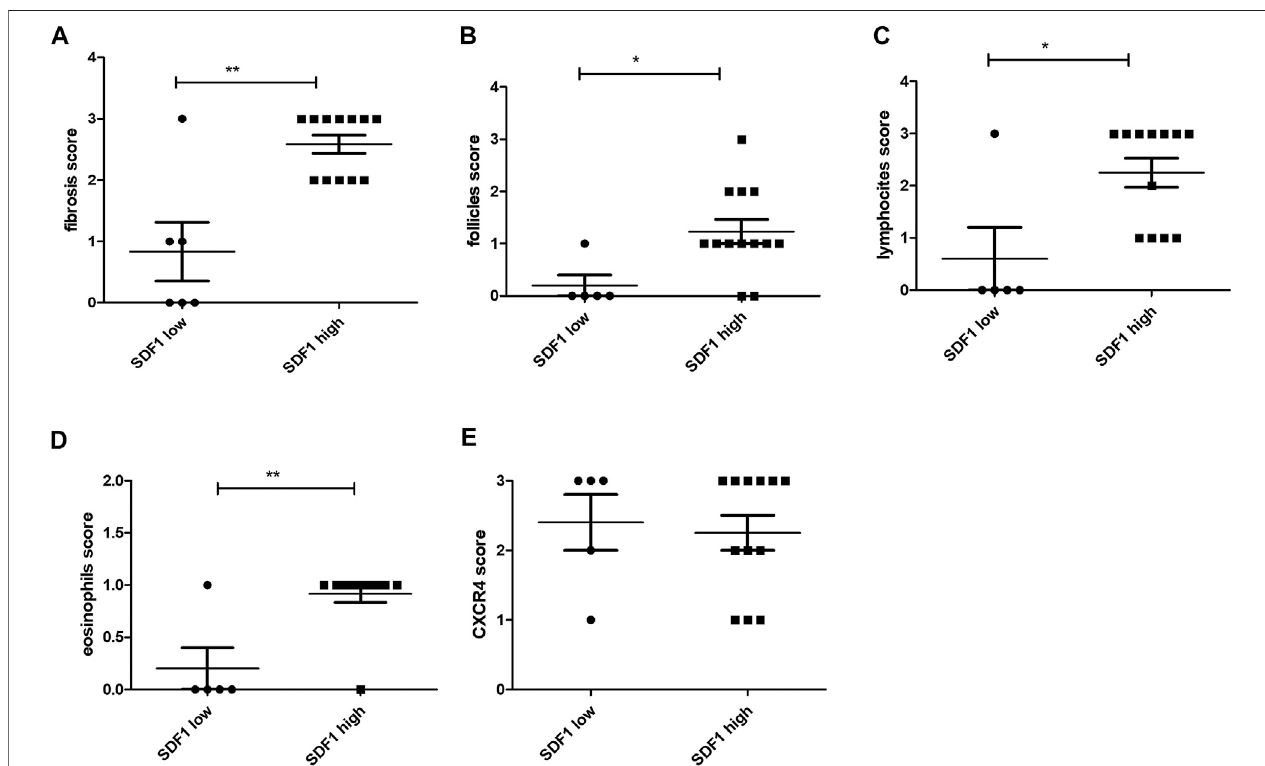
FIGURE3| SDF-1/CXCL12 expression inthepancreastissuerelatedtothe fi brosis score (A) ,thefollicle score (B) , thelymphocytescore (C) , theeosinophil score (D) , and the CXCR4 score (E) . p (cid:1) p < 0.05; pp (cid:1) p < 0.01.